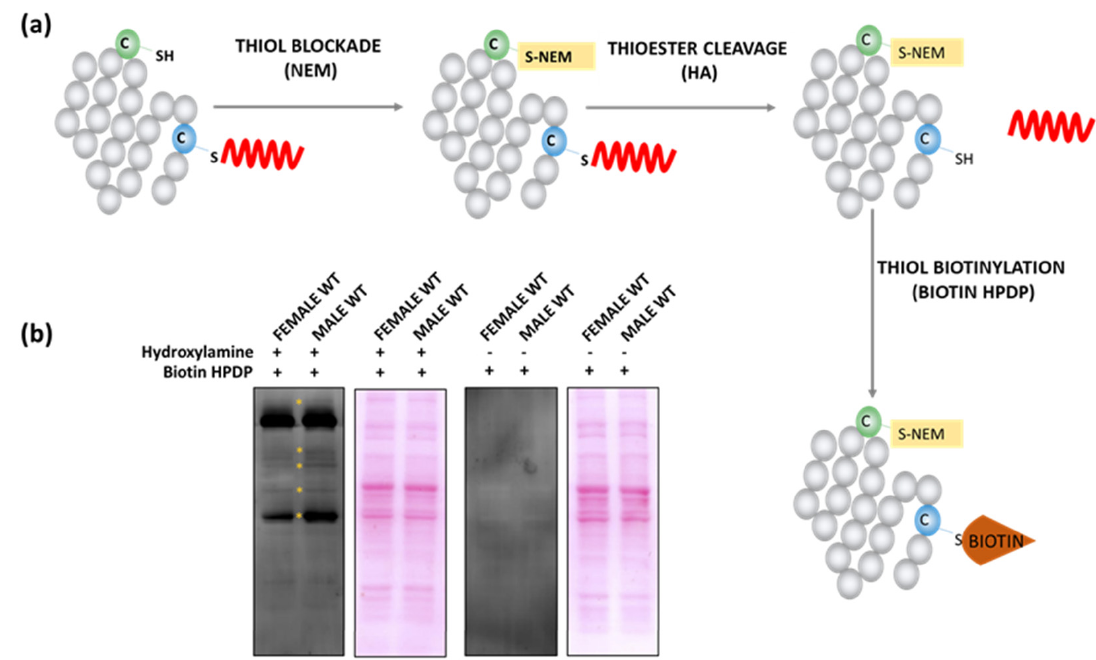
Figure 1. Analysis of S-PALM pattern in the female and male WT synaptoneurosomes. ( a ) Scheme of the applied ABE method. ( b ) Western blot analysis of the pattern of biotinylated proteins obtained with streptavidin-HRP antibody. Controls were prepared without selective cleavage of S-PALM thioester bonds by HA. Ponceau S staining was used as a loading control.